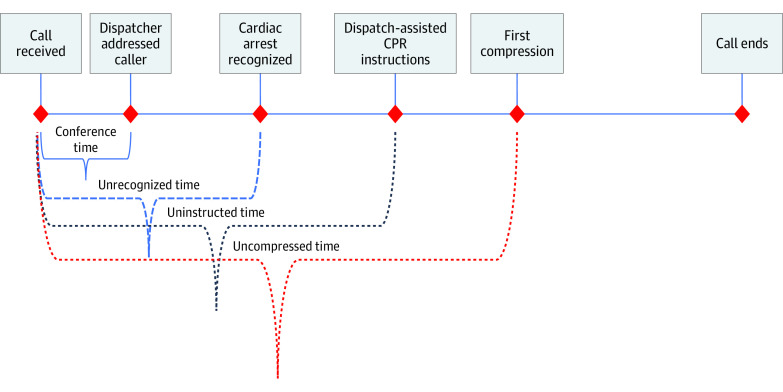
Timeline for Call to 112CPR indicates cardiopulmonary resuscitation.